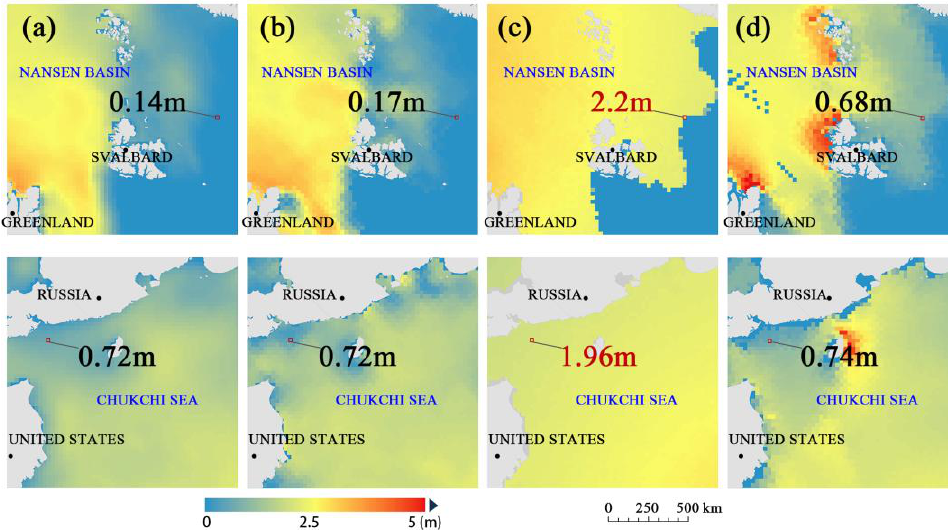
Figure 9. Comparison of the details of SIT distribution using different methods on 9 April 2020. Each column represents the SIT distribution of different methods. ( a ) SAC-Net thermodynamically estimated; ( b ) CS2SMOS estimated; ( c ) APP-x estimated; ( d ) PIOMAS estimated. Each row represents a comparison of different regions: NANSEN BASIN (first row) and CHUKCHI SEA (second row).